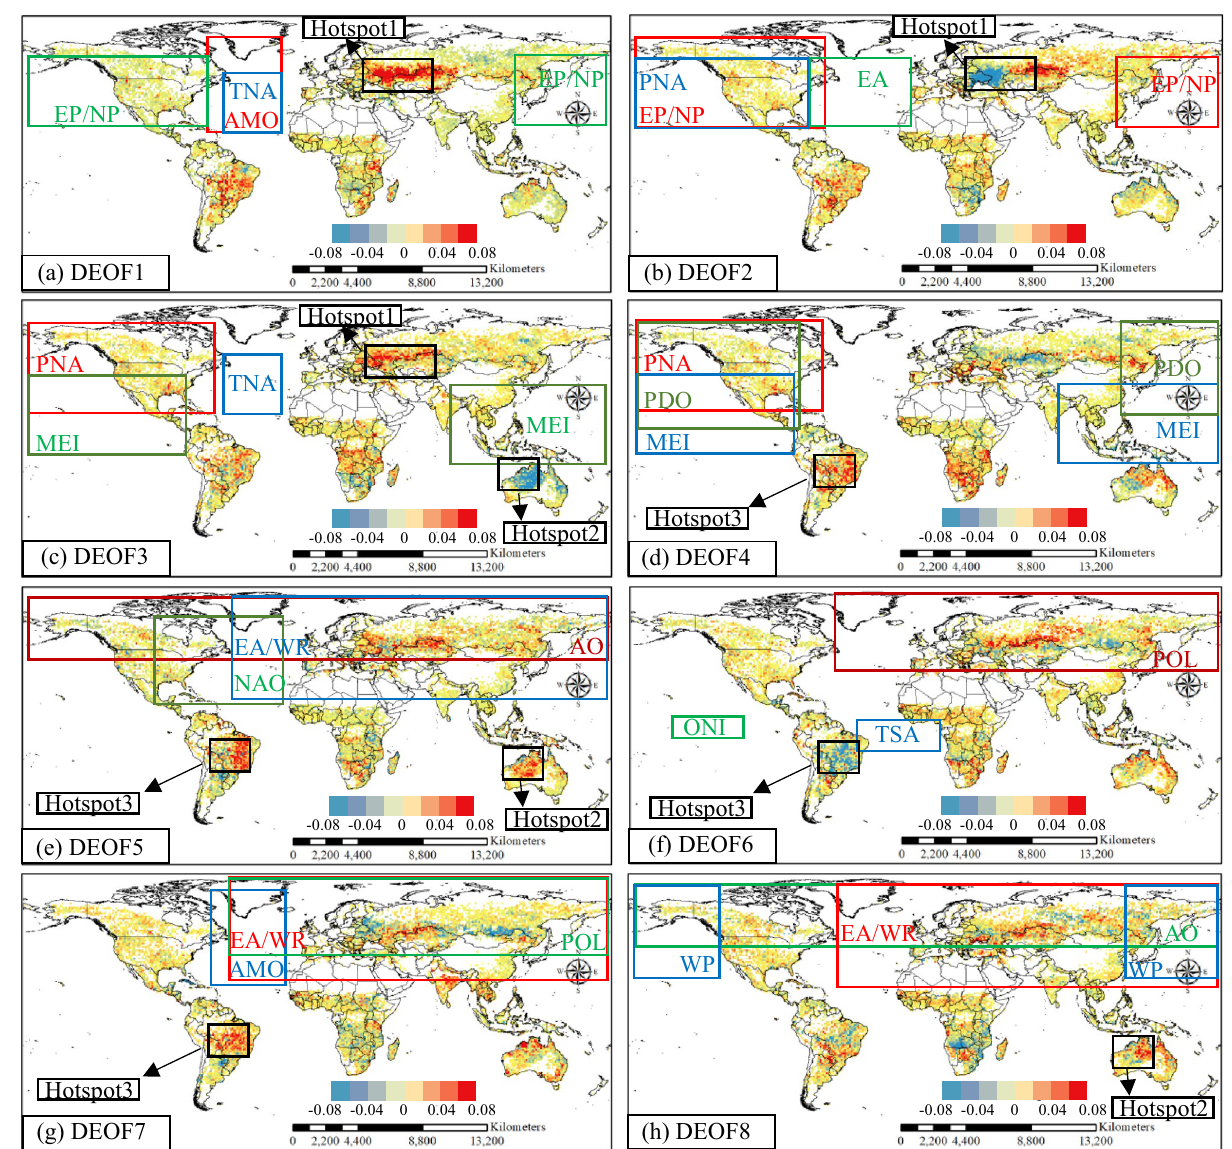
Figure 4. The location distribution of the top three global climatic drivers with the strongest influence on DEOF patterns. The red, blue and green rectangles indicate the strongest, second-strongest and third-strongest global climatic drivers on the DEOFs, respectively. The black circle indicates the common region in different patterns. Hotspot 1: around Ukraine and Kazakhstan; Hotspot 2: Australia; Hotspot 3: Brazil. This figure was generated using ArcGIS version 10.1 (https:// www. esri. com/ en- us/ home). The data used in the calculation comes from Fire CCI v5.1 dataset (https:// geogra. uah. es/ fire_ cci/ firec ci51. php) and NOAA (https:// psl. noaa. gov/ data/ clima teind ices/ list/). Shape for countries of the world downloaded from Geografía, SIG y Cartografía Digital. (http:// tapiq uen- sig. jimdo free.